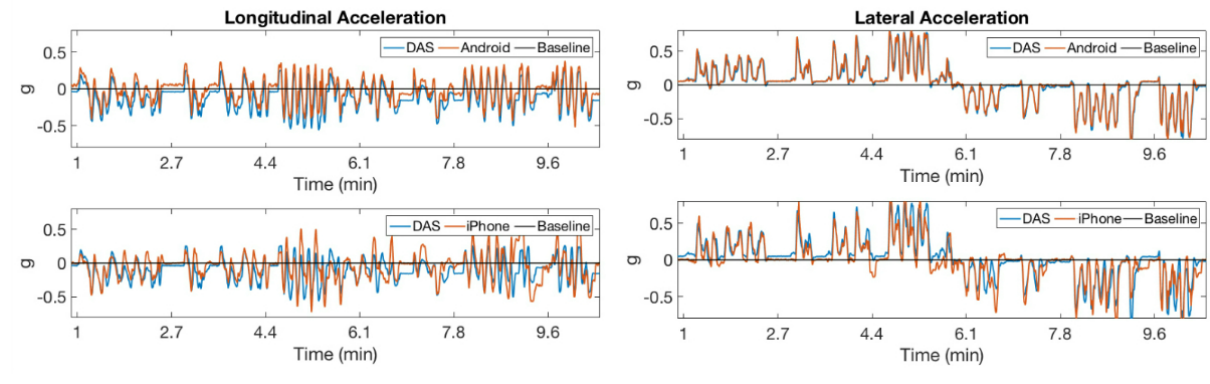
Figure 7. The effects of in-vehicle weight distribution on baseline acceleration measurements. While vehicle is stationary, the acceleration measurements should be zero. DAS: data acquisition